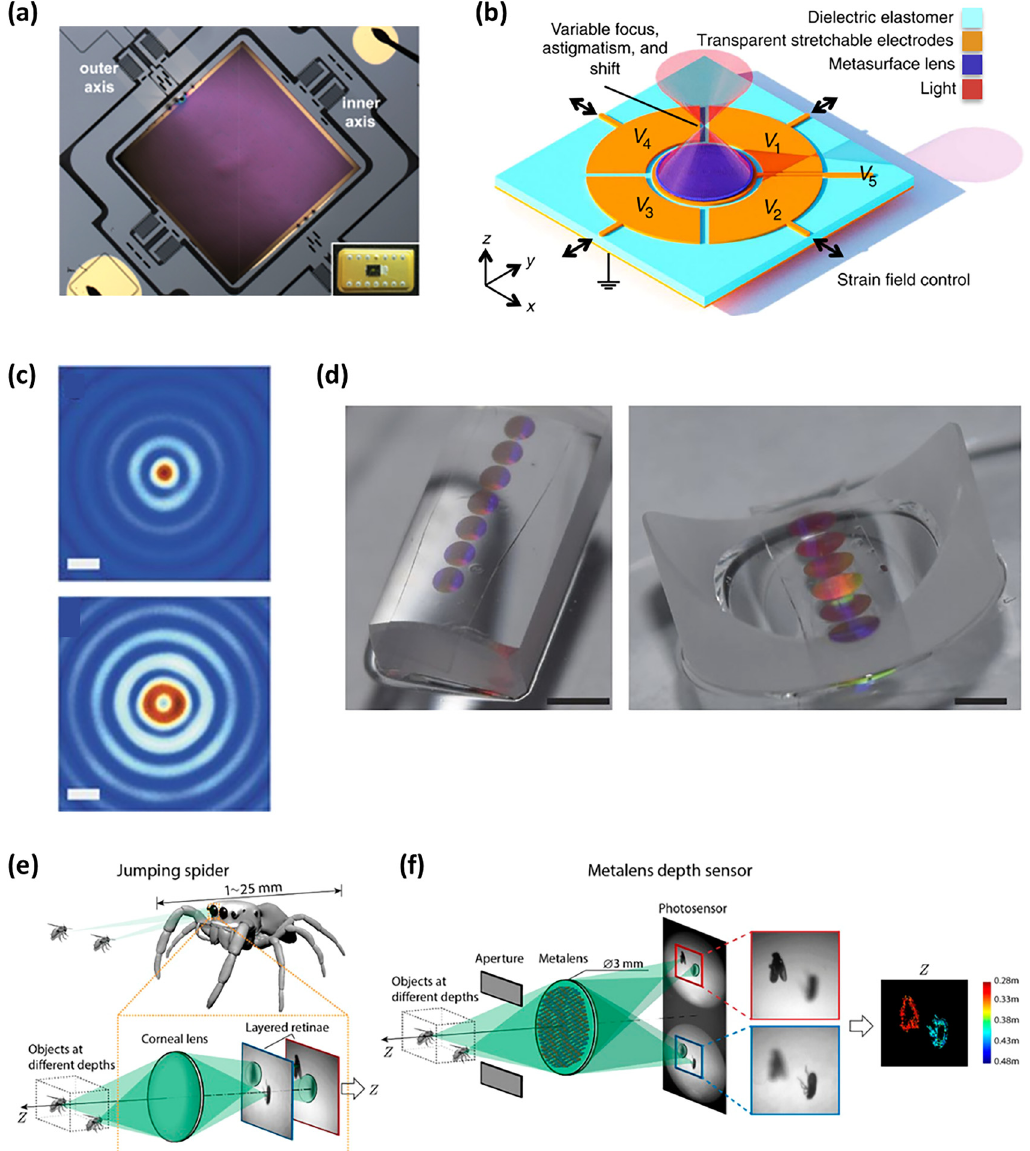
Figure 10: Future